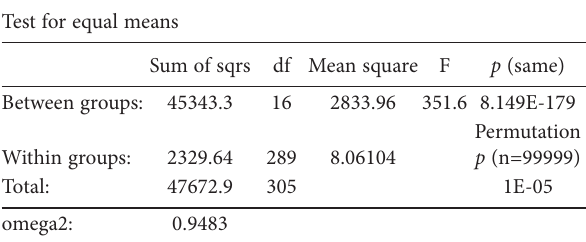
Table 4. One way ANOVA test